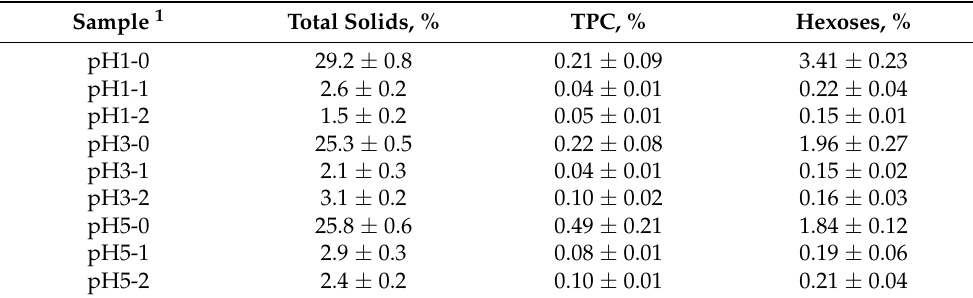
Table 1. Quantities of the solids, TPC, and hexoses in rinsing water of SA